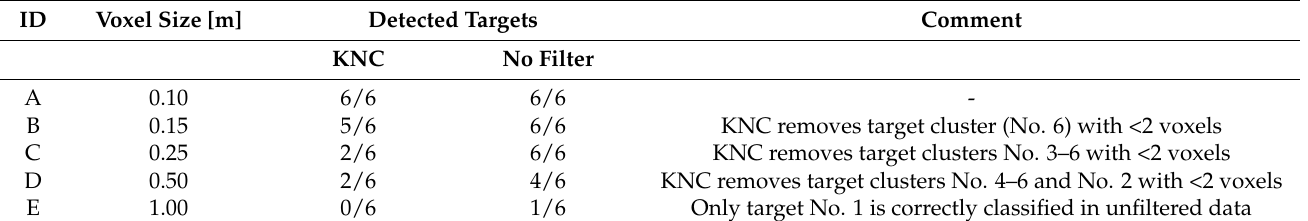
Table 2. Results of voxel-size sensitivity tests.